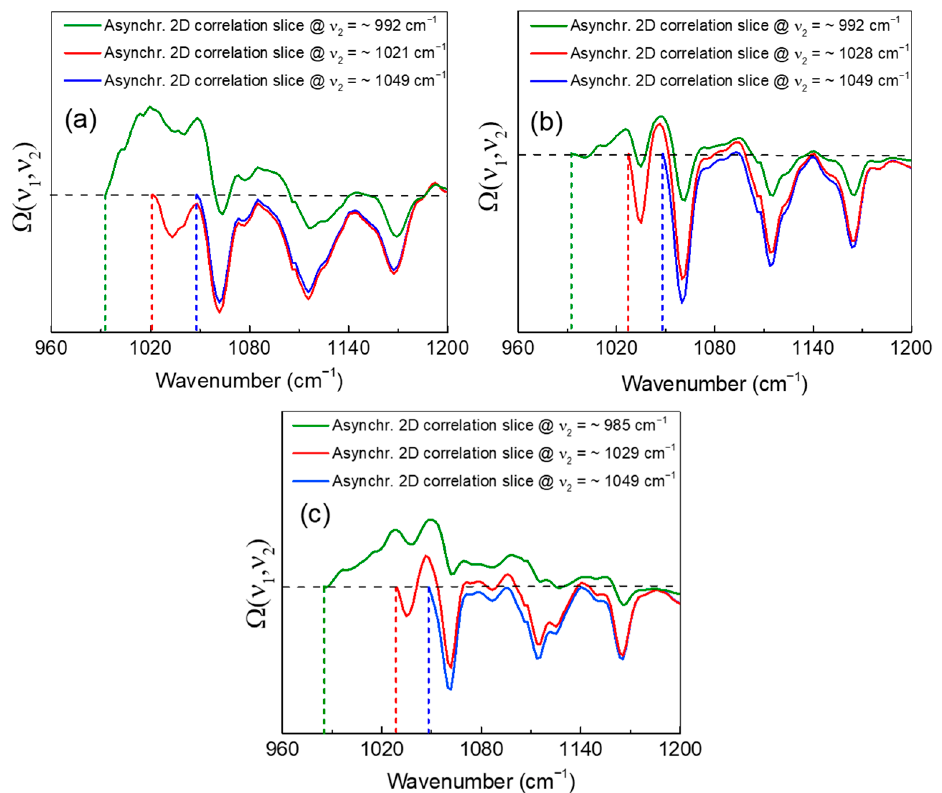
Figure 4. Asynchronous correlation slices at three different values of ν 2 for ( a ) CNS (0.2:1), ( b ) CNS (1:1) and ( c ) CNS (2:1) sample. The black dashed line in each panel accounts for the Θ ( v 1 , v 2 ) ~ 0 condition. Above and below this line, positive and negative correlations can be respectively observed. Being all information regarding the spectral sequence of events contained within the half region of the whole ACM for which v 1 > v 2 , the selected slices develop beyond the diagonal line of each map starting from those points for which v 1 = v 2 (colored vertical short-dashed